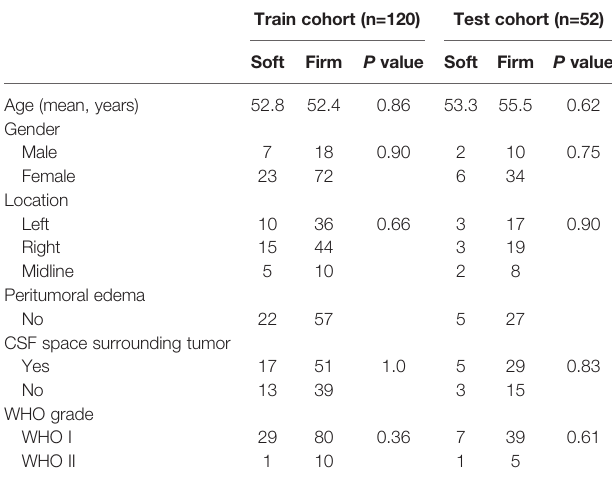
TABLE 1 | General characteristics of